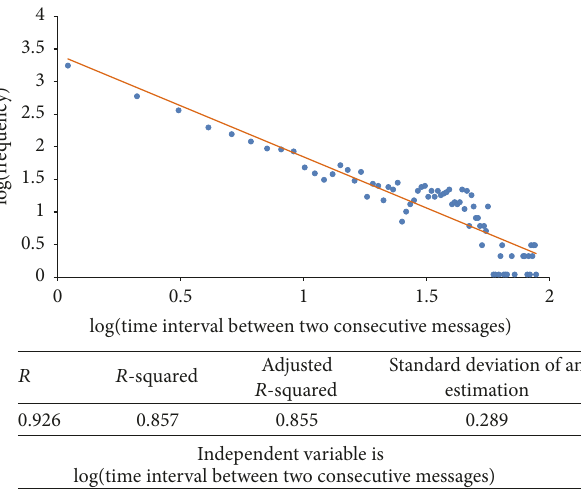
Figure 2: Time interval situation of mass incident.